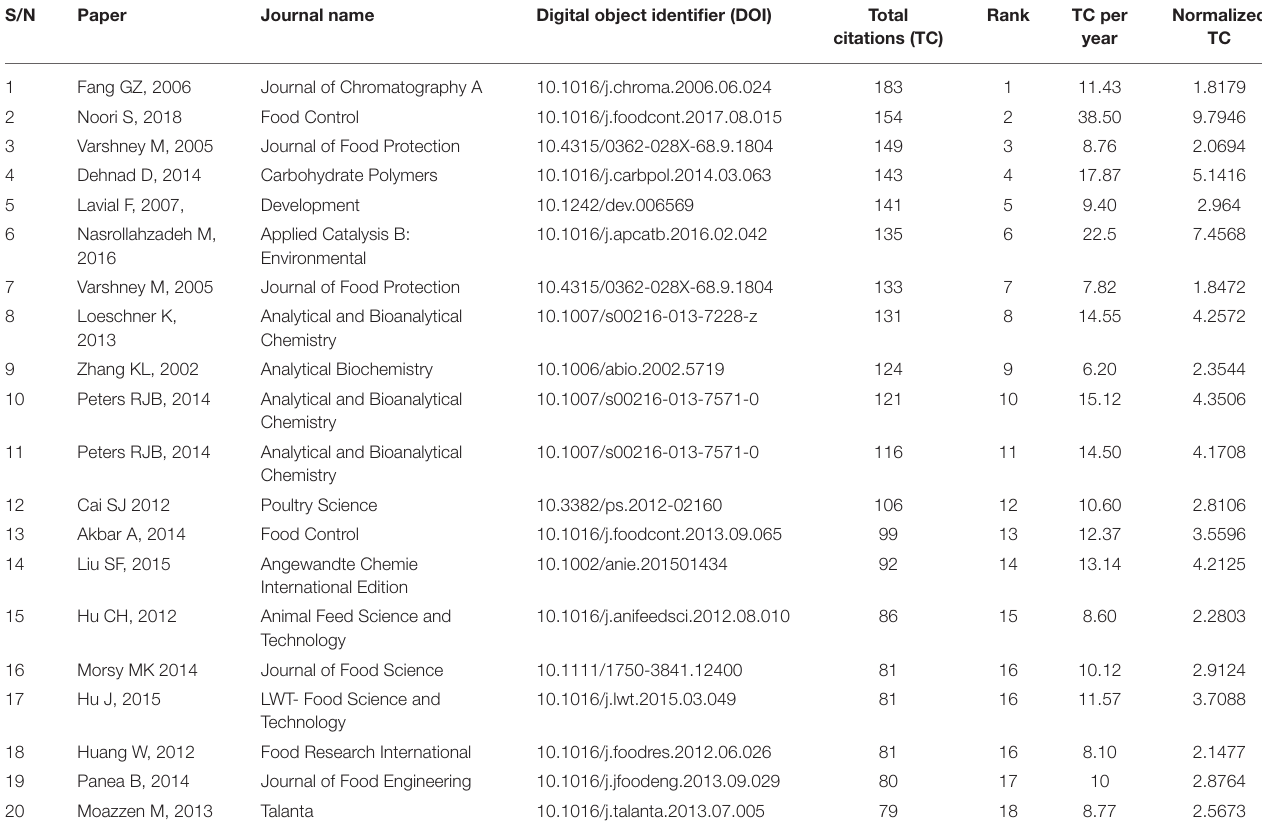
TABLE 6 | Top 20 most cited articles on meat production and nanotechnology.